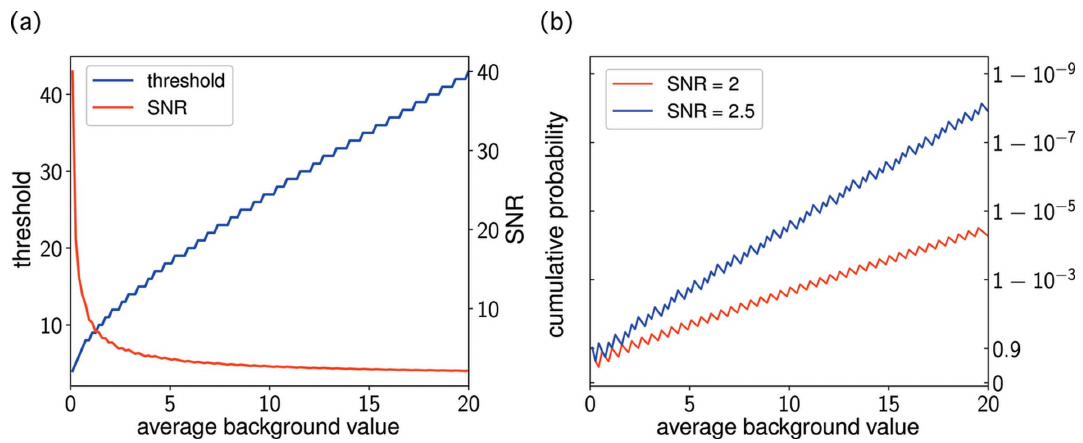
Figure 1 ( a ) The photon count thresholds determined by equation (1) with " = 10 (cid:3) 5 . The SNR is defined as the ratio of the thresholds to the background estimates. ( b ) The cumulative probabilities P b ( K (cid:5) b (cid:2) SNR) to measure a photon count K that is no larger than the thresholds b (cid:2) SNR, defined by fixed values of SNR over a range of background estimates b